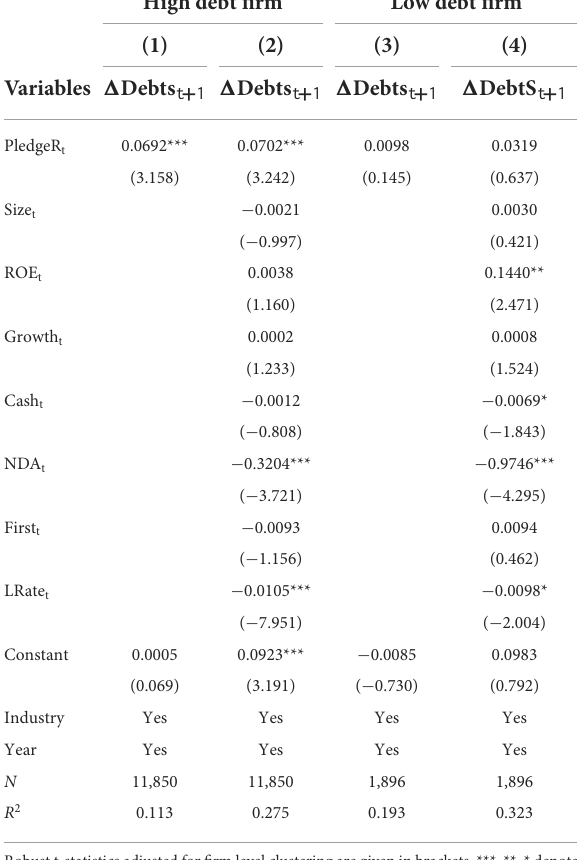
TABLE 6 The association between high leverage of ultimate owner and firm’s debt maturity structure. High debt